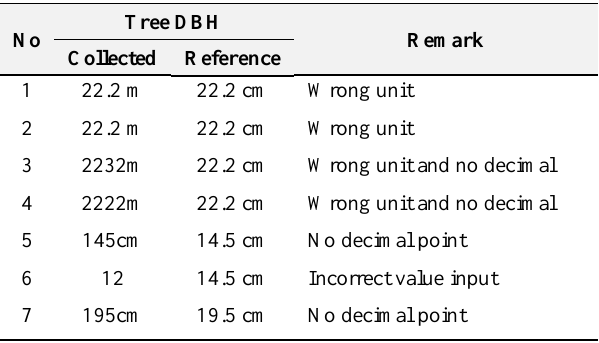
Table 12. The list of errors associates to tree DBH measurement in task 1 and the reference data.